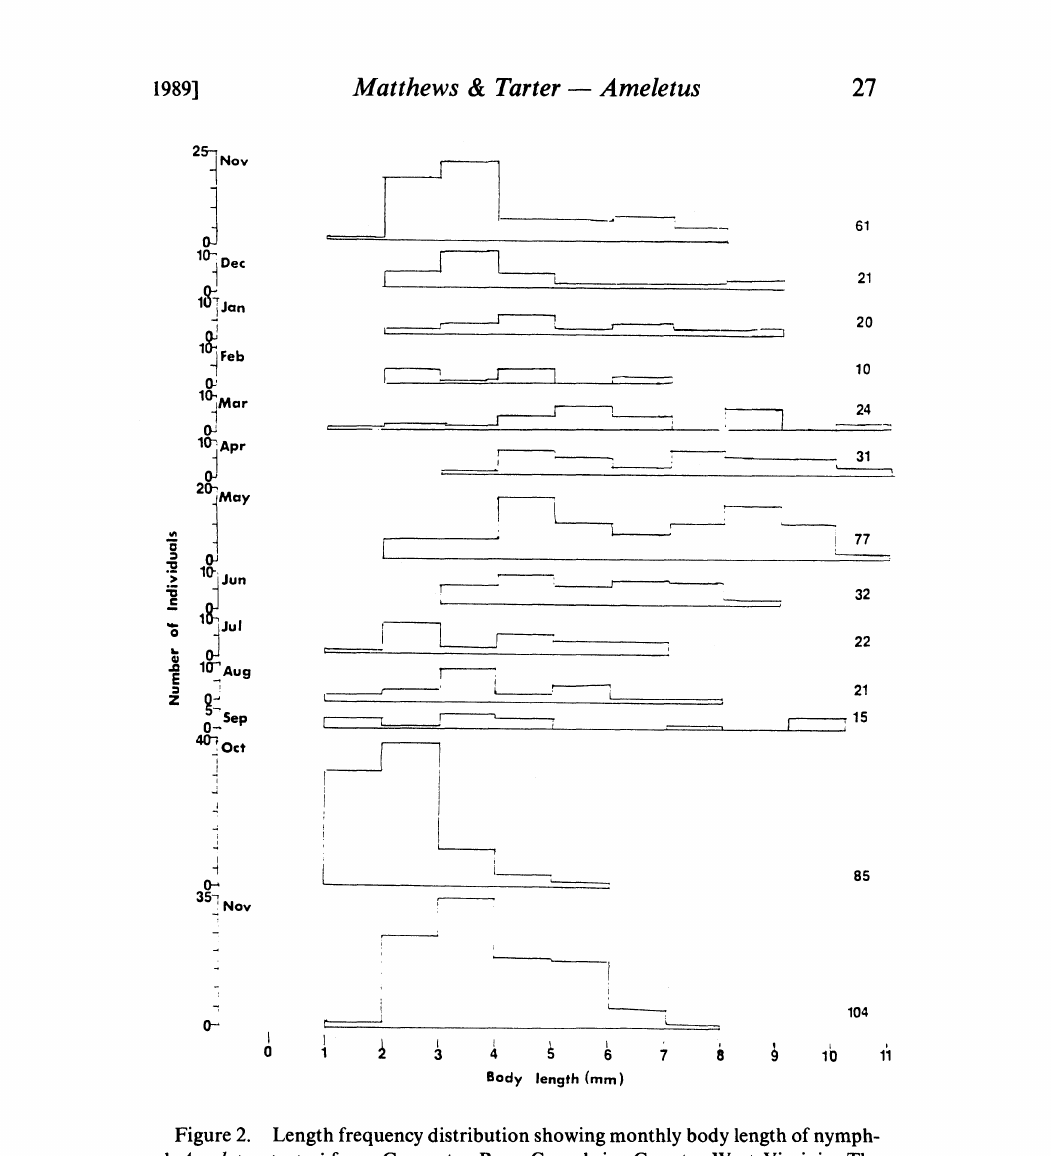
Figure 2. Length frequency distribution showing monthly body length of nymph- al Ameletus tarteri from Carpenter Run, Greenbrier County, West Virginia. The number of individuals collected per month is at the